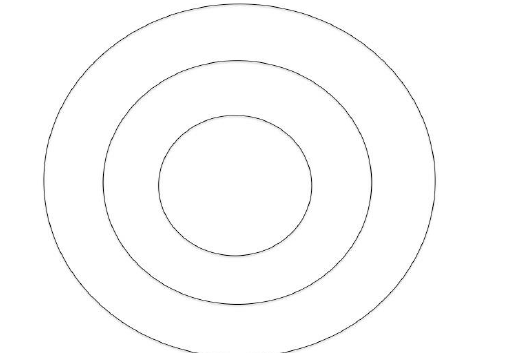
Figure 1. Diagram of students’ levels of participation in PE. The circles indicate different levels of participation with the inner circle representing the most participatory students and the outer circle representing the least par- ticipatory students. Students not participating at all were placed outside the